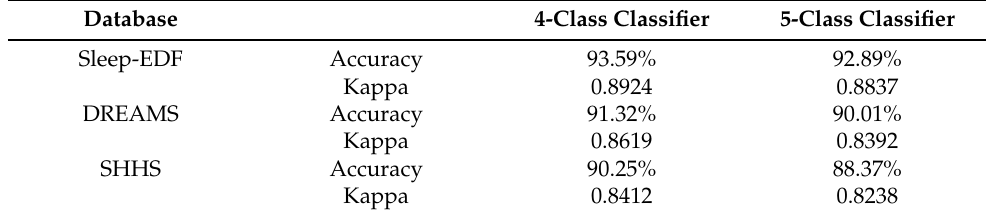
Table 6. Classification model accuracy and